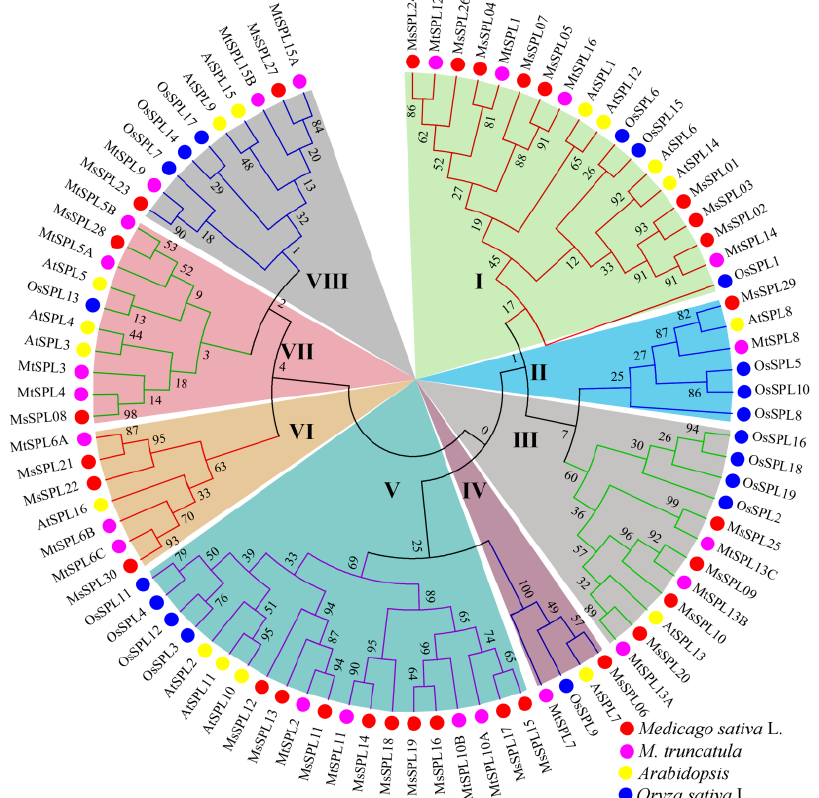
Figure 3. Unrooted phylogenetic tree representing the relationships among M. sativa , Arabidopsis , M. truncatula , and O.sativa . The different color background indicates the different subgroups. To examine the diversity in the MsSPLs, 10 conserved motifs were predicted (Figure